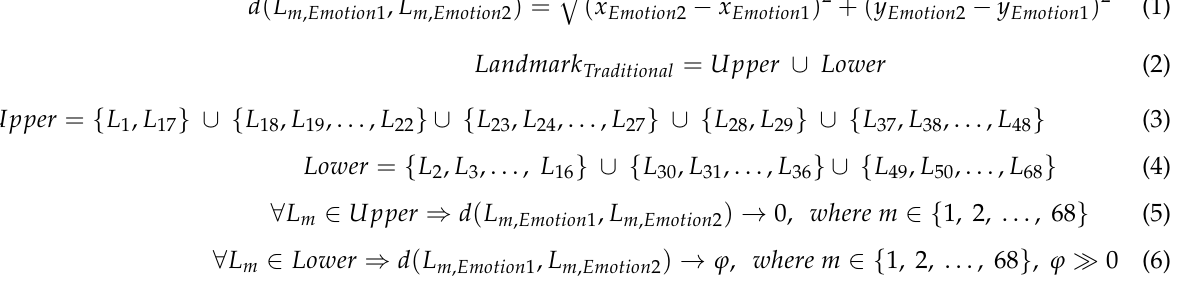
d ( L m , Emotion 1 , L m , Emotion 2 ) = Landmark Traditional = Upper ∪